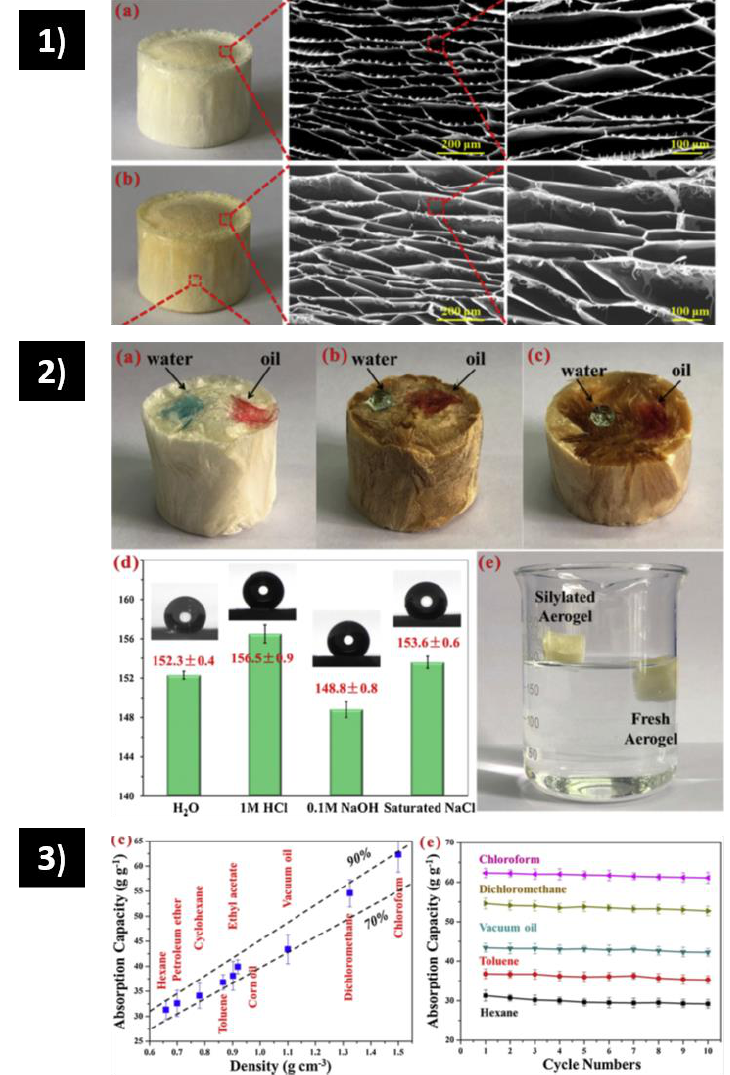
Figure 5. ( 1 ) Morphology and structure of CS aerogels during different fabrication stages. ( a ) Photograph of pristine aerogel and its cross-sectional SEM images; (b) Photograph of MTMS- modified CS aerogel and its longitudinal SEM images. ( 2 ) Surface wettability of the CS aerogel. ( a ) Photographs of water and oil droplets on the surface of freeze-fried CS aerogel; ( b ) Photographs of water and oil droplets on the MTMS-modified CS aerogel; ( c ) Photographs of water and oil droplets on the freshly cut surface of MTMS-modified CS aerogel; ( d ) Contact angles on the surface of the mod- ified sample for different liquids; ( e ) Images showing the floating of the modified sample in contrast to the sinkage of the fresh sample in the water. ( 3 ) Oil absorption property of the MTMS-modified CS aerogel. (c) The mass-based absorption capacity (g/g) for a wide spectrum of oils and organic solvents. The two dashed lines represent the theoretical volume-based absorption capacity ( v / v ) of 90% and 70% for modified aerogel, respectively. (e) Cyclic absorption capacities of the modified aerogel [89].